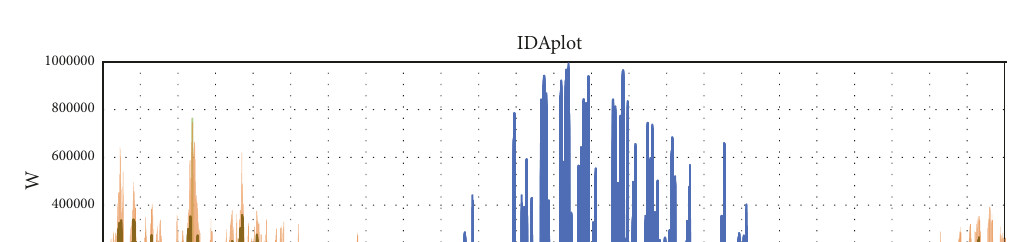
Figure 9: AHU 1 supply and return air flow.